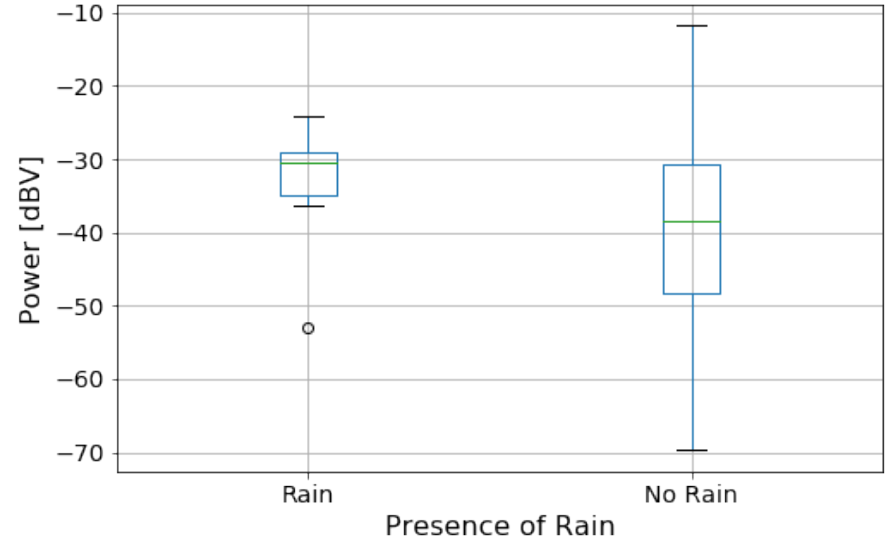
Figure 8. Box plot of data divided by presence of rain. Table 5. Model coefficients (with confidence interval in parenthesis) and goodness of fit metrics for rain vs. power linear model.